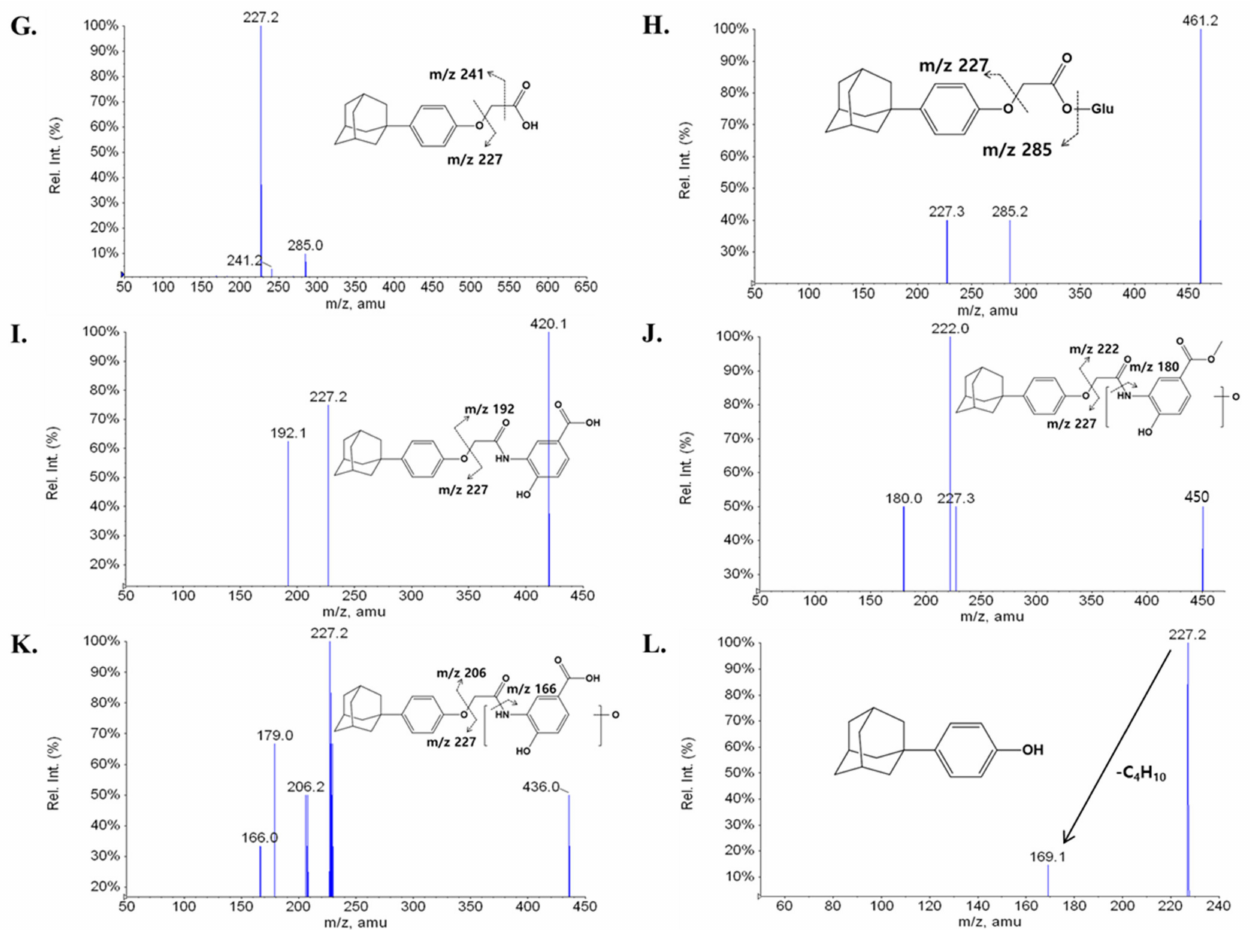
Figure 3. Enhanced product ion (EPI) spectra and proposed fragmentation patterns for the in vivo metabolites of